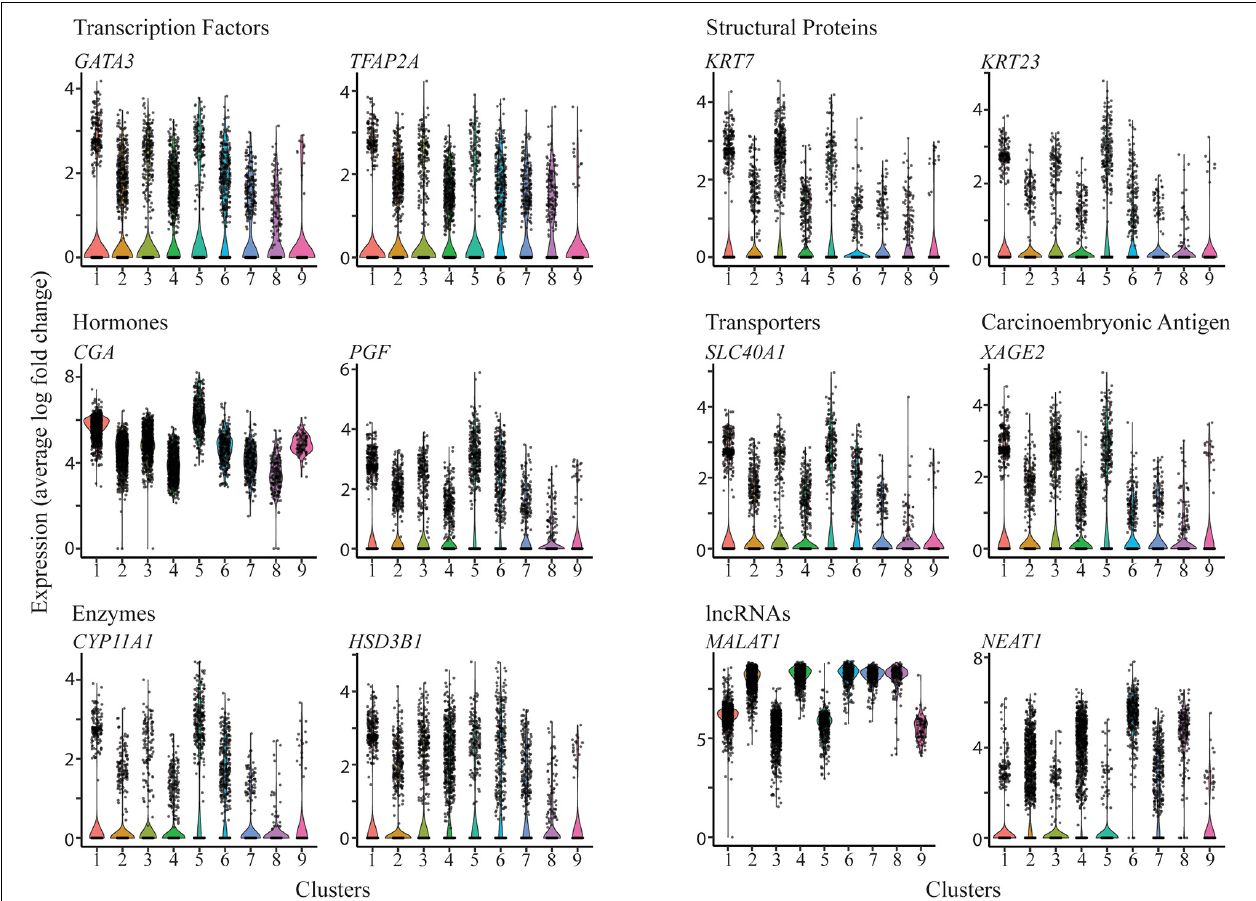
FIGURE 2 | Expression profiles of selected genes across the clusters. Violin plots showing expression for genes encoding transcription factors ( upper left panel ), structural proteins ( upper right panel ), hormones ( mid left panel ), transporters and carcinoembryonic antigen ( mid right panels ), enzymes involved in steroid biosynthesis ( lower left panel ), and long non-coding RNAs ( lower right panel